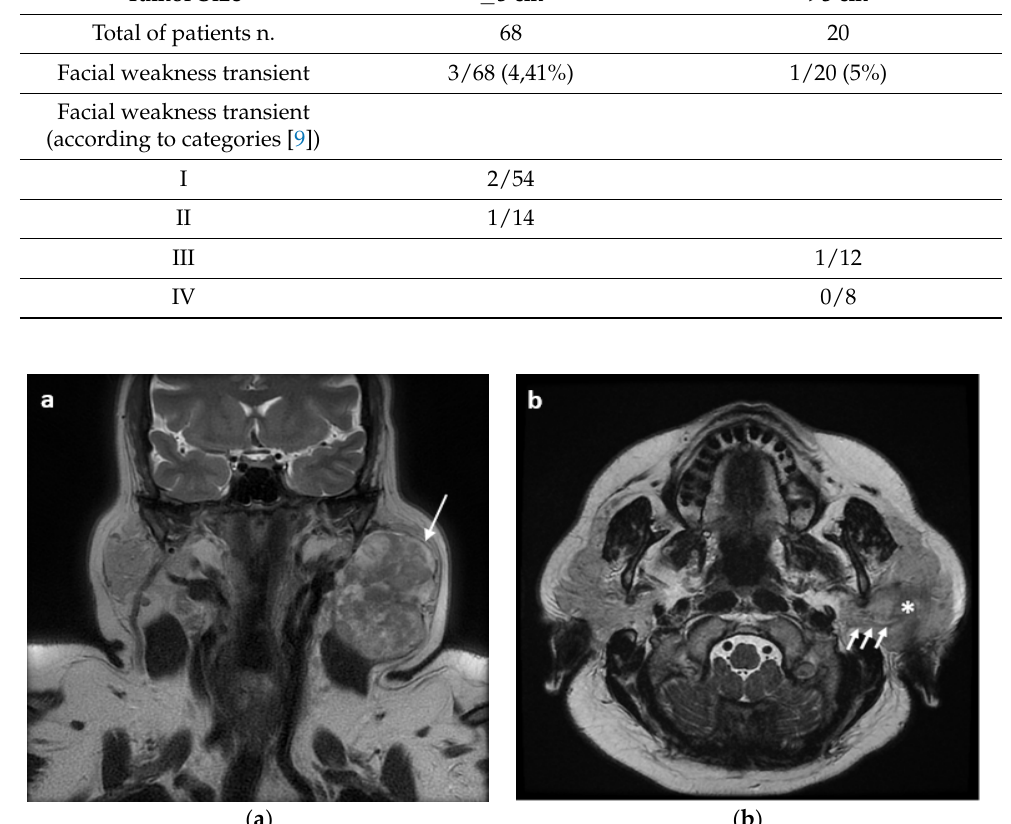
Figure 3. Representative histological examination of ECD of pleomorphic adenoma . ( A ) pleo- morphic adenoma with the excision margin marked with ink (black arrow) (H&E stain, 10× magni- fication, scale-bar 500 µm). ( B ) detail of the ECD with the integrity of the capsule of the neoplasm histologically observed (black arrowhead) (H&E stain, 20× magnification, scale-bar 200 µm). 4. Discussion Although the extension of the resection in the treatment of benign parotid tumors ranged from limited resections to total parotidectomy with preservation of the facial nerve [9,20–22], there is still a tendency to use limited surgeries, especially in small benign tu- mors [7–9,11,12]. The surgery procedure aims to obtain the best possible results in terms of complete removal of the tumor, risk of recurrence, and postoperative outcome with preserved FN function. The rate of temporary postoperative paresis of the facial nerve is reported in the